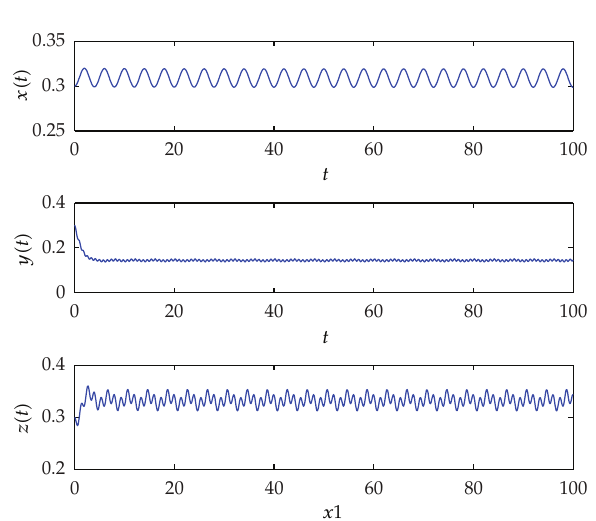
Figure 1: T (cid:9) R , m (cid:9) 0 . 6. Dynamics behavior of system (cid:6) 4.1 (cid:7) with initial condition x (cid:6) 0 (cid:7) (cid:9) 0 . 3, y (cid:6) 0 (cid:7) (cid:9) 0 .